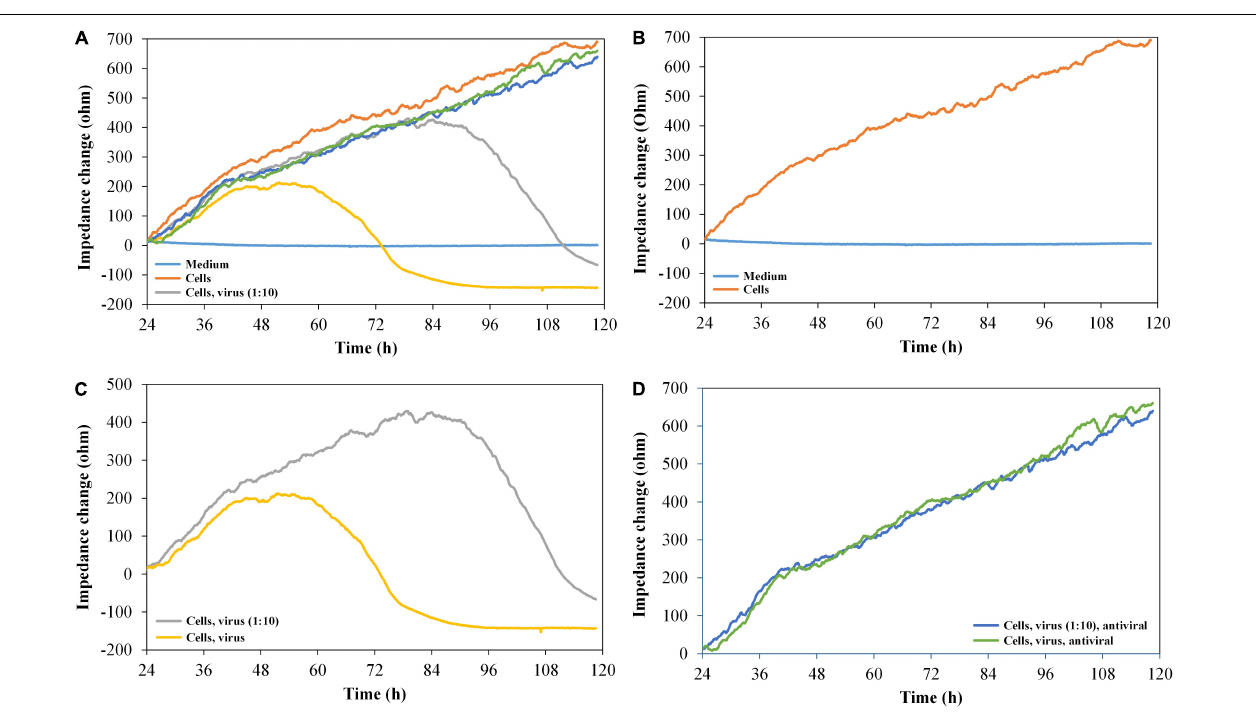
FIGURE 5 | Impedance change curves of vero cells, exposed to HSV-1 and antiviral substance pritelivir, n = 2. (A) Impedance curves of all six channels. (B–D) show two selected curves each from (A) . (B) Medium control and cells without virus. (C) Cells with 500 IFU/ml of HSV-1 SC16 cl-2 virus and 1:10 diluted virus. (D) Cells with virus, undiluted (500 IFU/ml) and 1:10 diluted in the presence of 1 µ M of the antiviral agent pritelivir. All the curves were set to 0 (cid:127) at t = 24 h (infection with HSV-1/addition of pritelivir). The slope of medium average was corrected to 0, and all other curves were modified